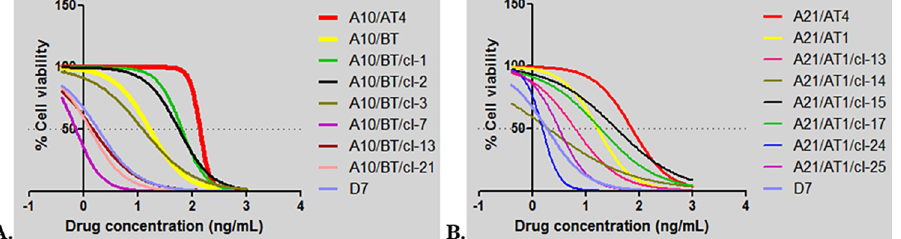
Fig 5. MTT assay of cloned cell lines from A10/BT (A) and A21/AT1 (B) isolates. Numbers on the x axis (-1, 0, 1, 2, 3 and 4) indicates drug concentrations used to treat cell lines at doses of 0, 0.8, 7, 125, 1000 and 1500 ng/mL, respectively.